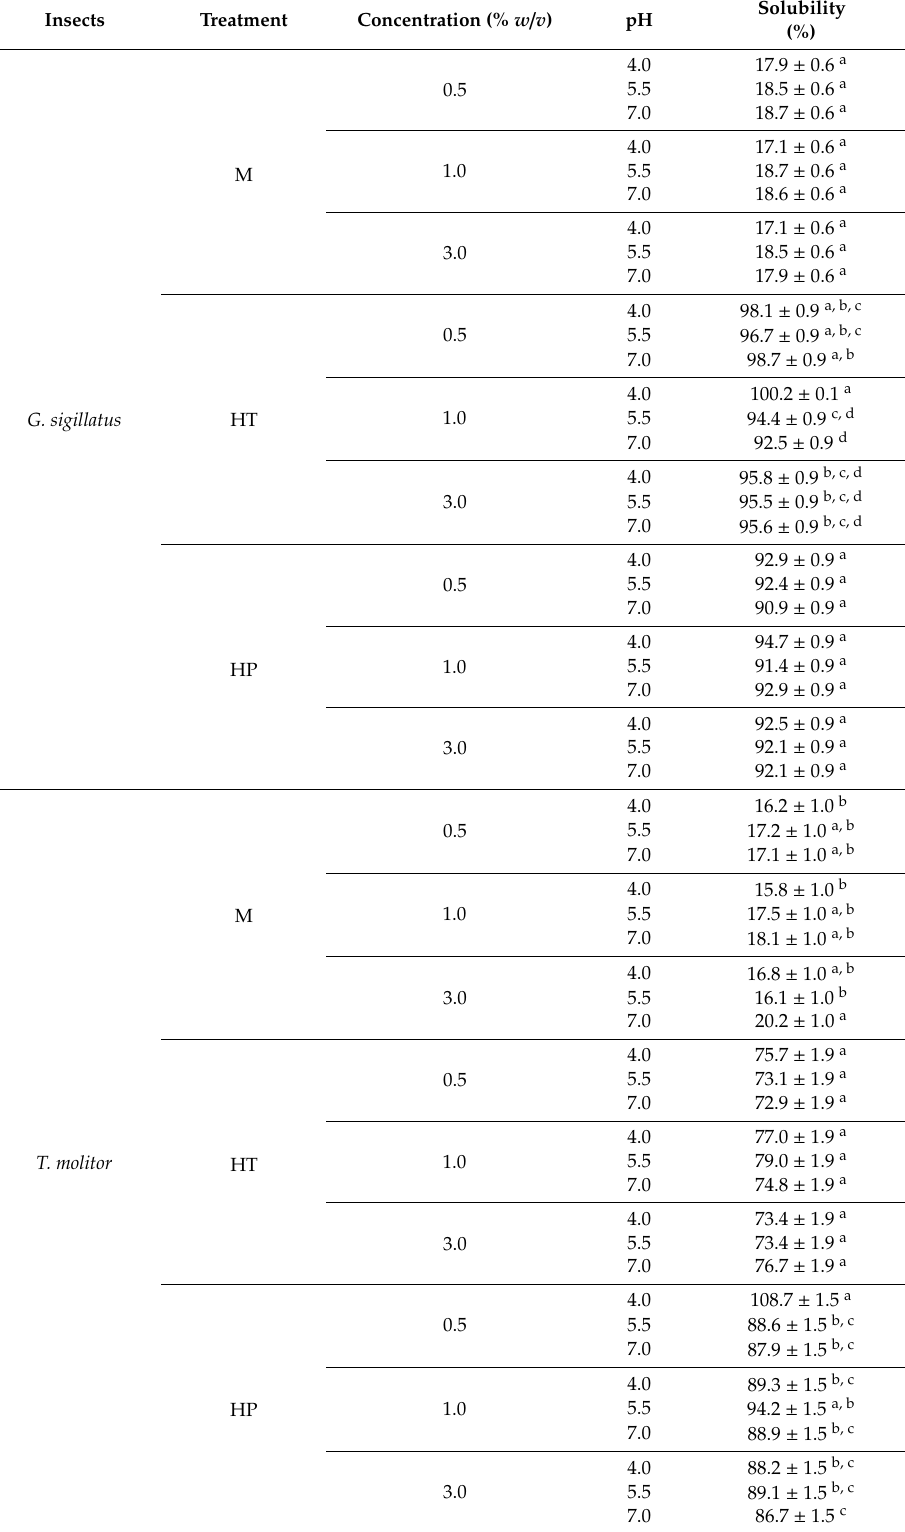
Table 3. Solubility of cricket and mealworm meals and hydrolysates at di ff erent concentrations and pH values, generated with or without HHP pretreatment before enzymatic digestion. Insects